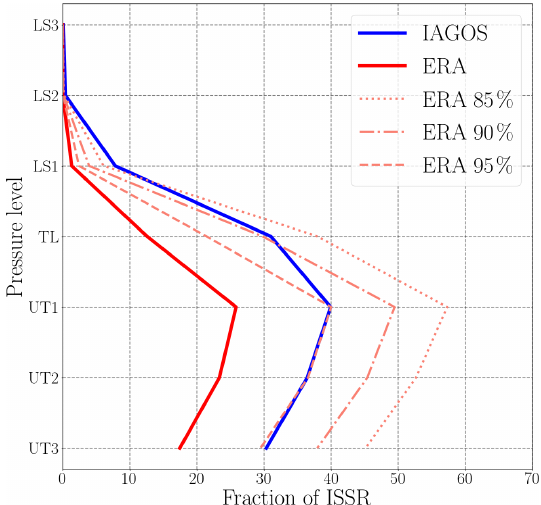
Figure 6. Vertical profile of the fraction of ice supersaturated re- gions for IAGOS (blue) and ERA (red). Different definitions of ice supersaturation in ERA are shown in light red. The dotted line rep- resents the fraction of RH iERA ≥ 85% , the dashed–dotted line de- picts the fraction of RH iERA ≥ 90%, and the dashed line stands for the RH iERA ≥